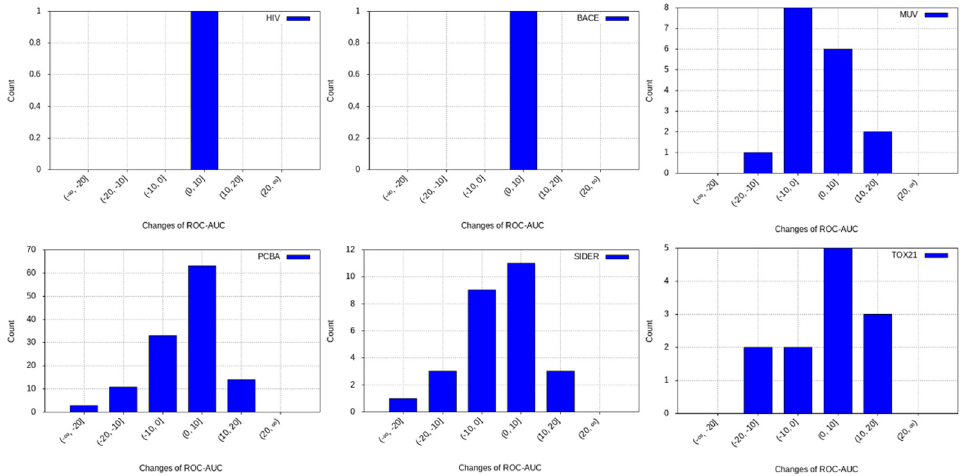
Figure A2. ROC-AUC curves on target test dataset for: ( a ) baseline model; ( b ) best performing model after transfer learning.